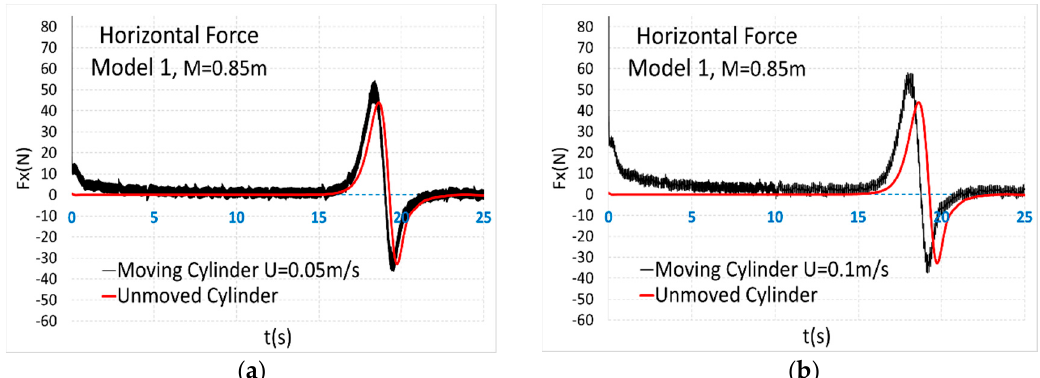
Figure 8. The time variation of the horizontal forces for model 1. ( a ) A comparison between the unmoved cylinder (red line) and the moving cylinder at U c = 0.05 m/s. ( b ) A comparison between the unmoved cylinder (red line) and the moving cylinder at U c = 0.1 m/s.